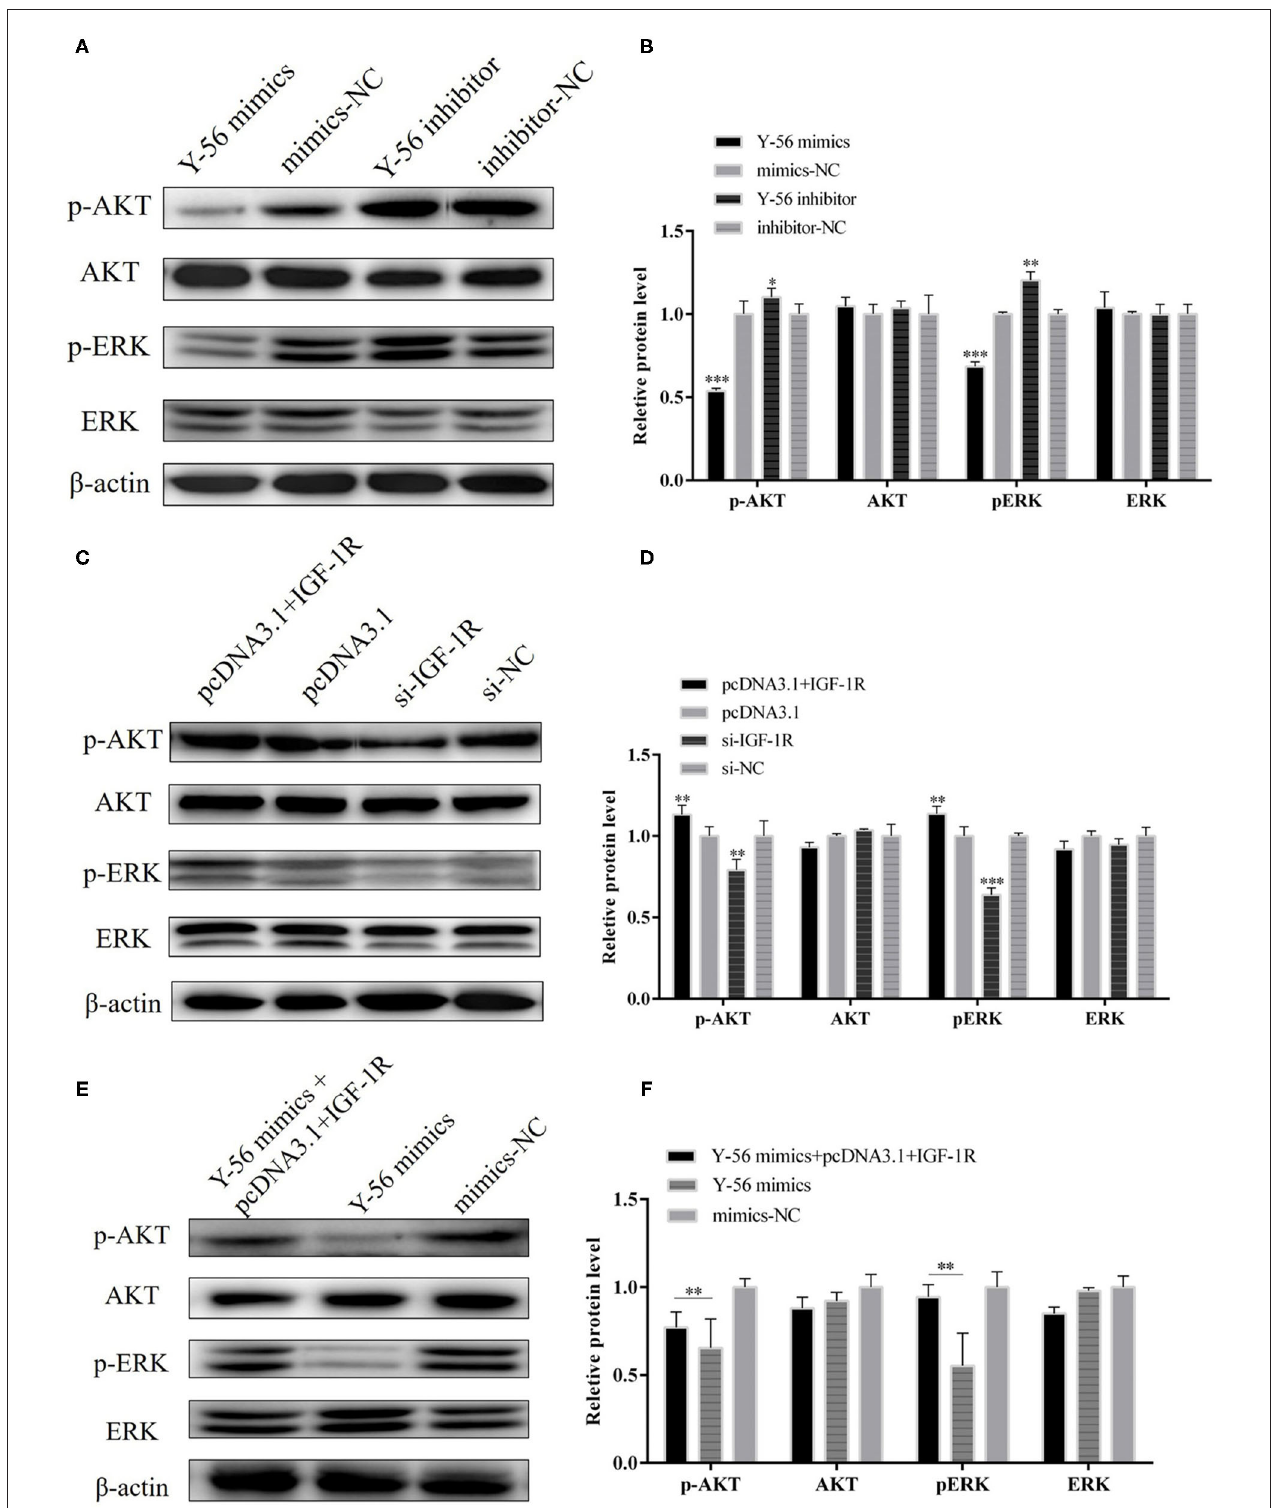
FIGURE 8 | Y-56 inhibited AKT and ERK signaling pathways in PSCs. (A,B) The protein expression of p-AKT, AKT, p-ERK, ERK after transfection of Y-56 mimics and Y-56 inhibitor in the PSCs. (C,D) The protein expression of p-AKT, AKT, p-ERK, ERK after transfection of 1GF-1R and si-1GF-1R in the PSCs. (E,F) The protein expression of p-AKT, AKT, p-ERK, ERK after co-transfection of IGF-1R and Y-56 mimics in the PSCs. Results are shown as mean ± SEM, and the data are representative of at least three independent assays. Independent sample t -test was used to analyze the statistical differences between groups (* P < 0.05, ** P < 0.01, and *** P <